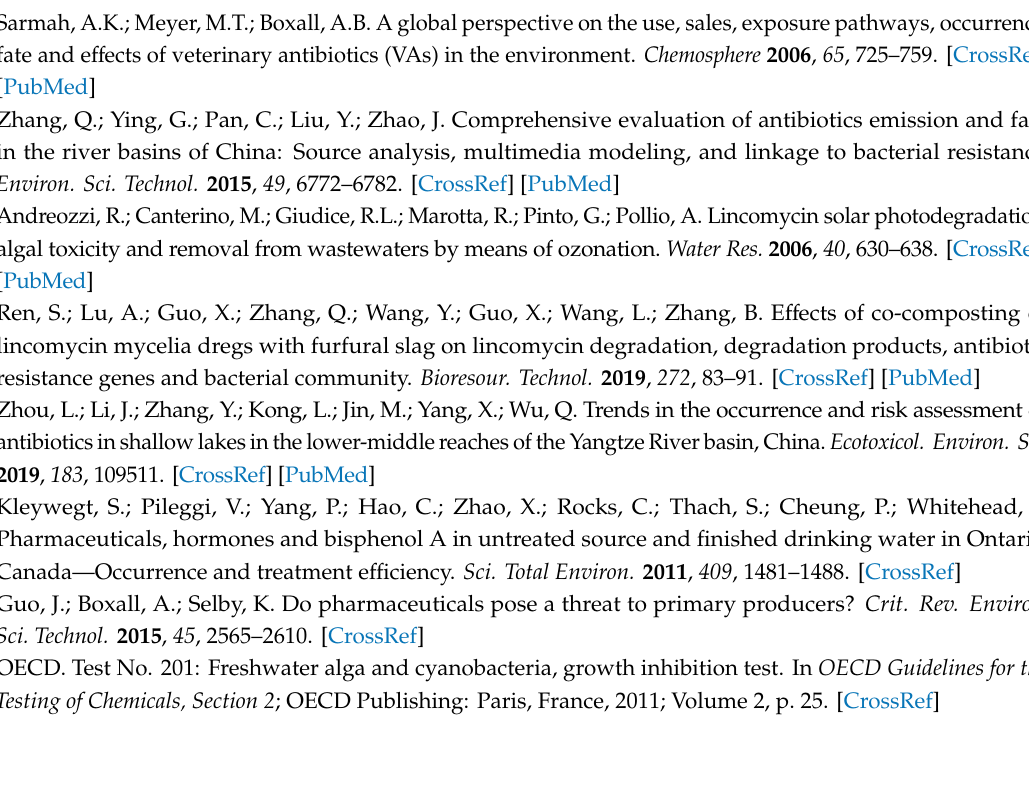
Figure S1: Volcano plot of gene expression profile in three treatment groups, Figure S2: The results of qRT-PCR, Figure S3: GO enrichment analysis of di ff erentially expressed genes (DEGs) in three lincomycin treated